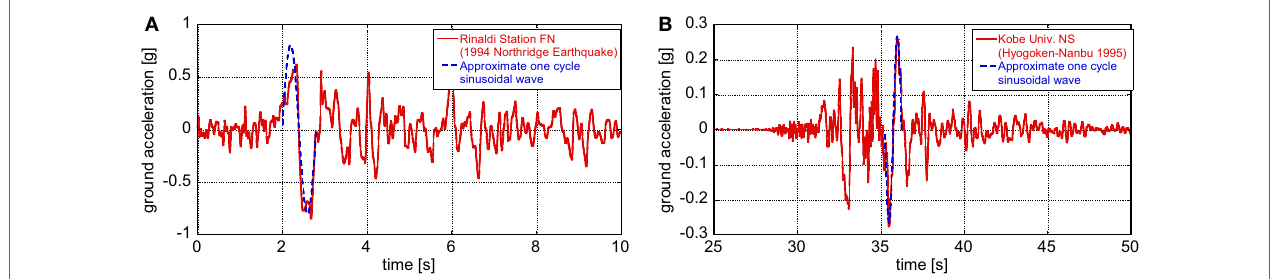
FIGURE 1 | Simplification of main part of actual pulse-type ground motion into one-cycle sine wave: (A) fault-normal component at Rinaldi station (Northridge earthquake 1994), (B) NS component (almost fault-normal) at Kobe University [Hyogoken-Nanbu (Kobe) earthquake 1995] (Kojima and Takewaki, 2016).